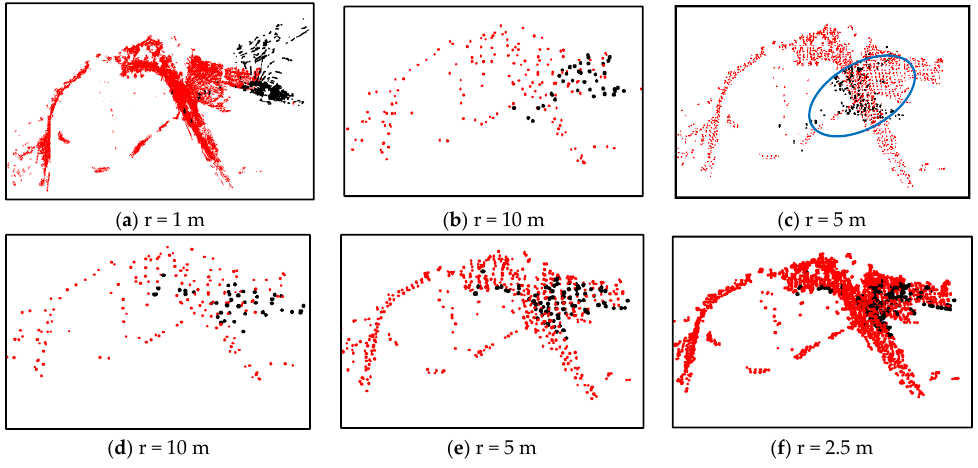
Figure 7. Heuristic escape: ( a ) shows the original transformation; ( b – f ) show the multi-resolution registration with the heuristic escape; the registration process hits a local optimal in the blue circle of ( c ); ( d ) shows the heuristic escaping transformation; ( e – f ) shows the following registration process.